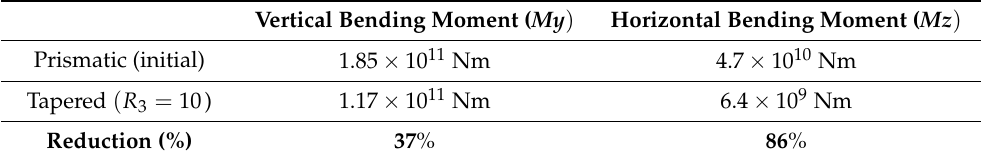
Table 1. A comparison of the critical wave bending moments. In the table, “prismatic” refers to the initial design (see Figure 9) and “tapered” refers to the improved design (see Figure 11). Vertical Bending Moment ( My ) Horizontal Bending Moment ( Mz